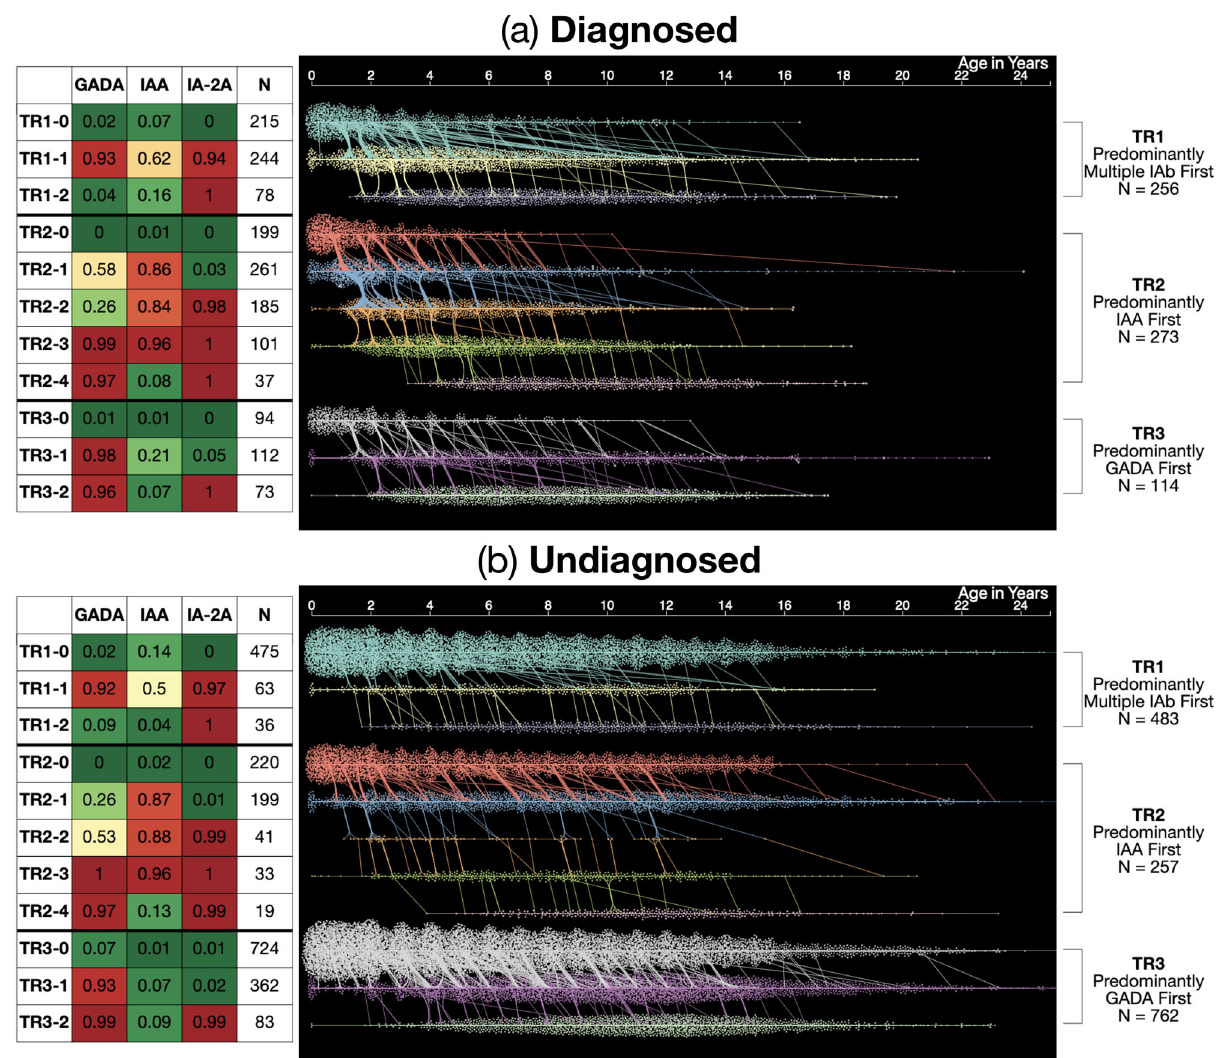
Fig. 1 Three data-driven islet autoantibody trajectories towards type 1 diabetes. The three trajectories discovered by the 11-state Hidden Markov model for ( a ) Diagnosed (D, 643 participants who were diagnosed with type 1 diabetes) and ( b ) Undiagnosed (UD, 1502 participants who were not diagnosed with type 1 diabetes during follow-up). Probabilities of islet autoantibody positivity for each of the 11 states are described in the table on the left, showing probabilities of each islet autoantibody for each state in text and color (heat map scale: green: 0, red: 1). Waterfall diagrams on right show visits (dots), HMM states ( y -axis & color) of participants over time in years (x-axis). The three trajectories were characterized with respect to their fi rst islet autoantibody positive states, respectively: TR1 Predominantly Multiple IAb fi rst (256 P, 483 NP); TR2 Predominantly IAA fi rst (273 P, 257 NP); TR3 Predominantly GADA fi rst (114 P, 762 NP). Source data are provided as a Source Data fi